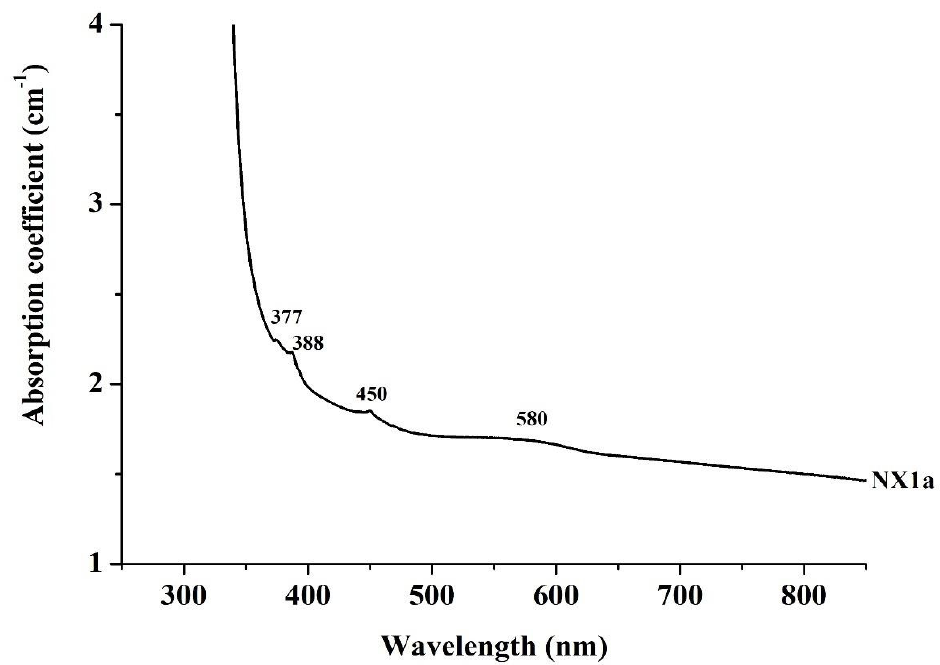
Figure 10. UV-Vis spectra from 250 to 850 nm of the light colored sapphire NX1a from (Kinidaros) Naxos Island. Figure 8 exhibits the absorption spectra of the light pink, slightly purple, sapphire GO5a and the blue sapphire GORa from Gorgona. Sample GO5a shows the same absorption bands in the visible range as the samples presented in Figure 7, with the chromium related bands situated at 400 and 560 nm and the iron related narrow bands situated at 377, 388 and 450 nm having lower intensity. Chromium related bands do not appear in the